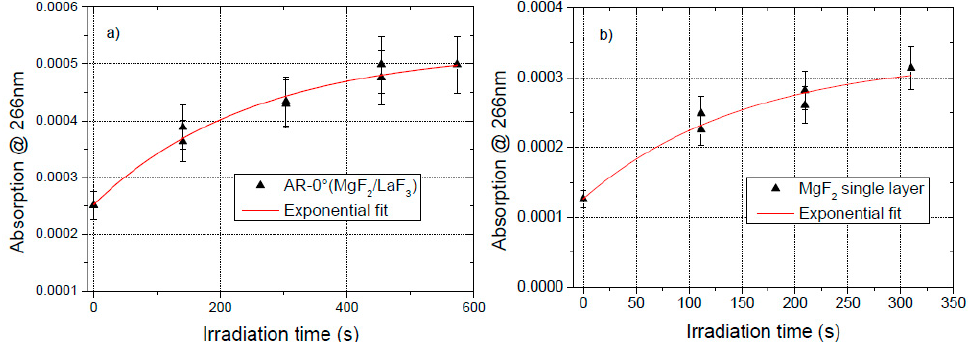
Figure 8. Absorption vs. laser irradiation time at 266 nm for ( a ) an AR-0° coating based on MgF 2 /LaF 3 thin films, ( b ) an MgF 2 single layer deposited identically to the MgF 2 part of the AR coating.